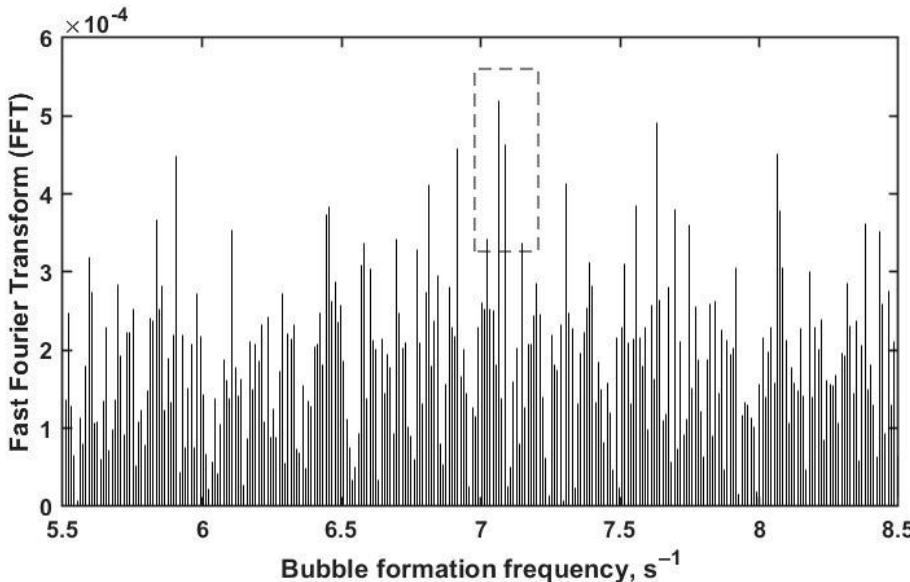
Figure 3. Application of the Fast Fourier Transform (FFT) to audio signals using a 0.006 m × 0.004 m injector submerged 0.11 m from the surface of the melt and a gas flow rate of 0.21 L/min. Table 3. Characteristics of the bubbles injected into the molten white metal during the conversion experiments described in Table